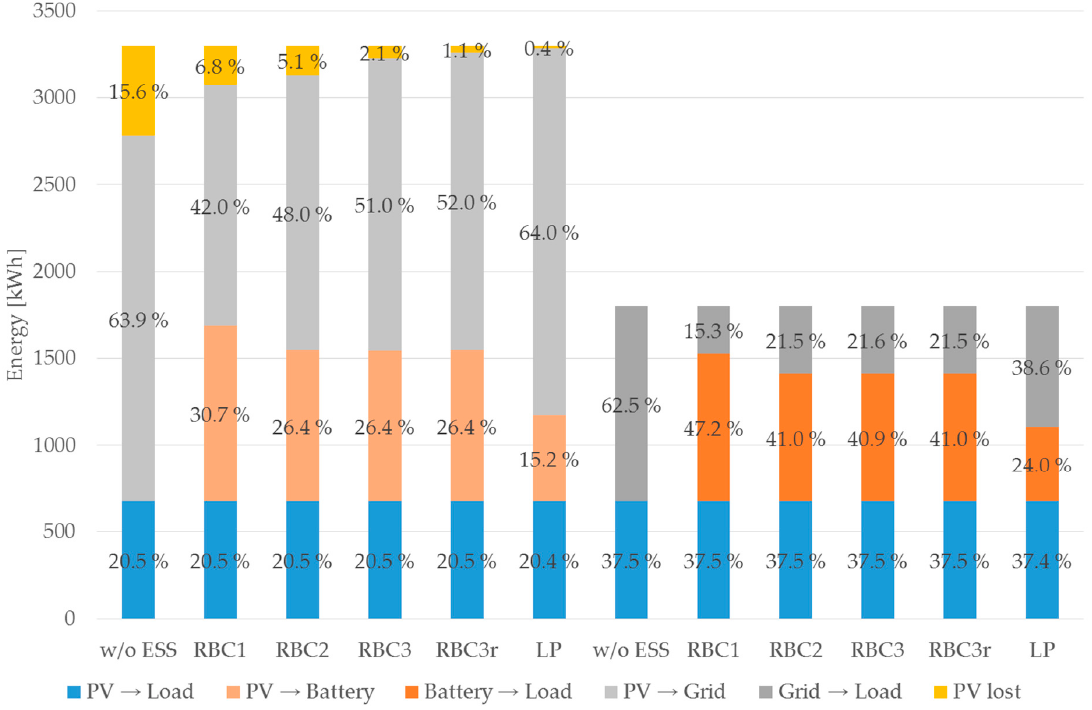
Figure 17. Energy balance on the PV side (left) and load side (right).